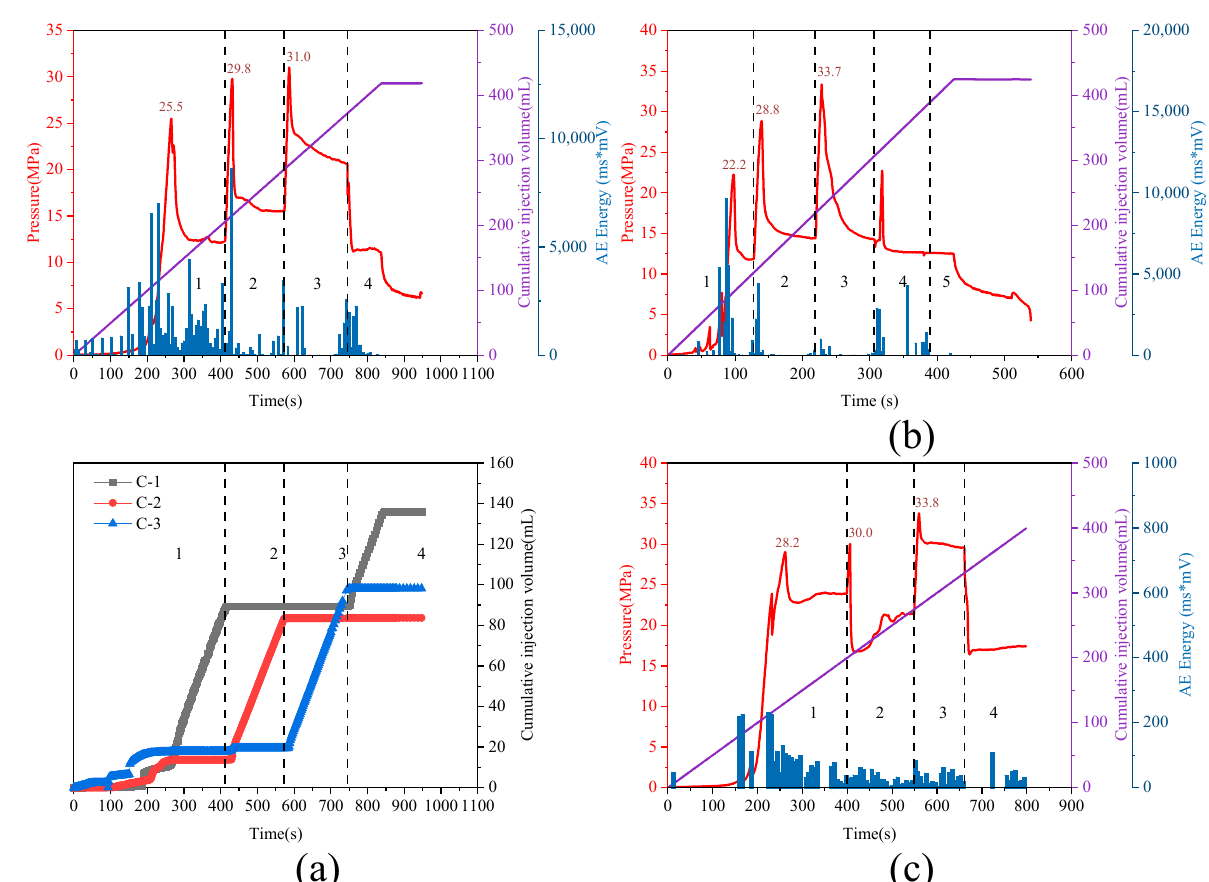
Figure 7. Pressure, cumulative injection volume, and acoustic emission energy curves: ( a ) Test 3 (top: pressure curve; bottom: cumulative injection volume of each channel); ( b ) Test 4; ( c ) Test 5.